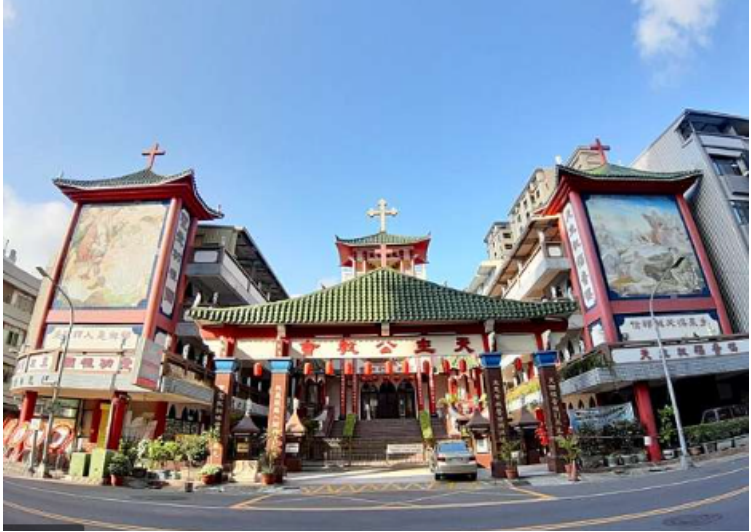
Figure 8. The church of Saint Caterina da Siena in Kaohsiung 高 雄 聖 加 大 利 納 堂 .